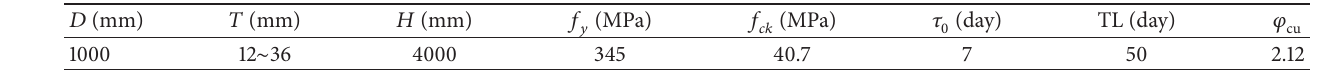
Table 8: Parameters of column needed in calculation.